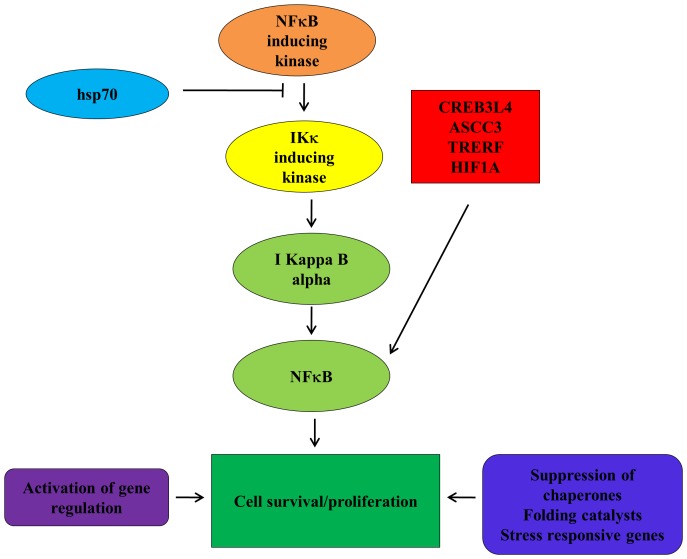
Proposed hypothesis for the mechanism of action of DMA.From gene expression analysis, important inducers of NFκB-CREB3L4, TRERF, ASCC3, HIF1A and MAP3K14 were observed to be activated. Moreover, HSP70 was found to be downregulated which inhibits NFκB activation at the level of I kappa B Kinase. Suppression of chaperones, folding catalysts, stress responsive genes in DMA treated cells further adds onto cellular proliferation. Thus, in cells treated with DNA minor groove binding ligand DMA, induction of NFκB inducing kinase and related transcription factors converges onto the propagation of the pro-survival signal.